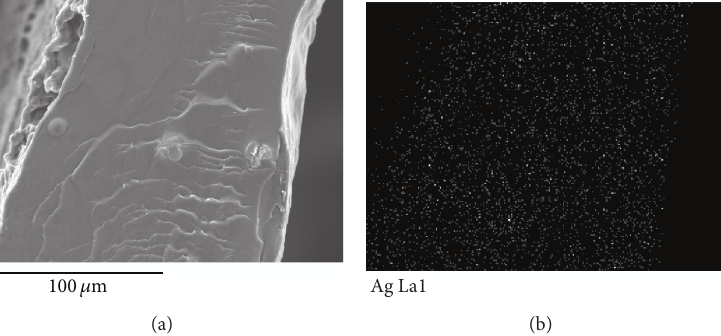
Figure 3: Representative SEM images show (a) the cross-section of SF-CS-PVA film incorporated with AgNPs at a concentration of 2,160 ppm and (b) collected EDS signal of silver over the cross-sectional